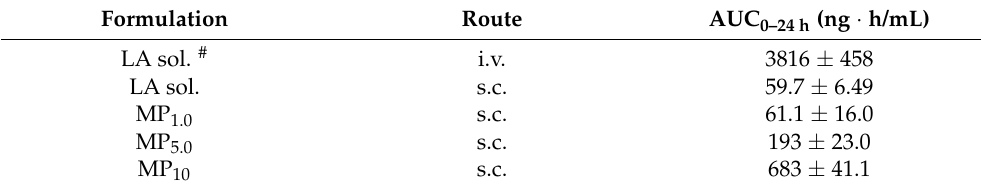
Table 3. Calculated AUC after i.v. or s.c. administration of formulation. Formulation Route AUC 0–24 h (ng · h/mL) LA sol. # i.v. 3816 ± 458 LA sol. s.c. 59.7 ± 6.49 MP 1.0 s.c. 61.1 ± 16.0 MP 5.0 193 ± 23.0 MP 10 683 ±